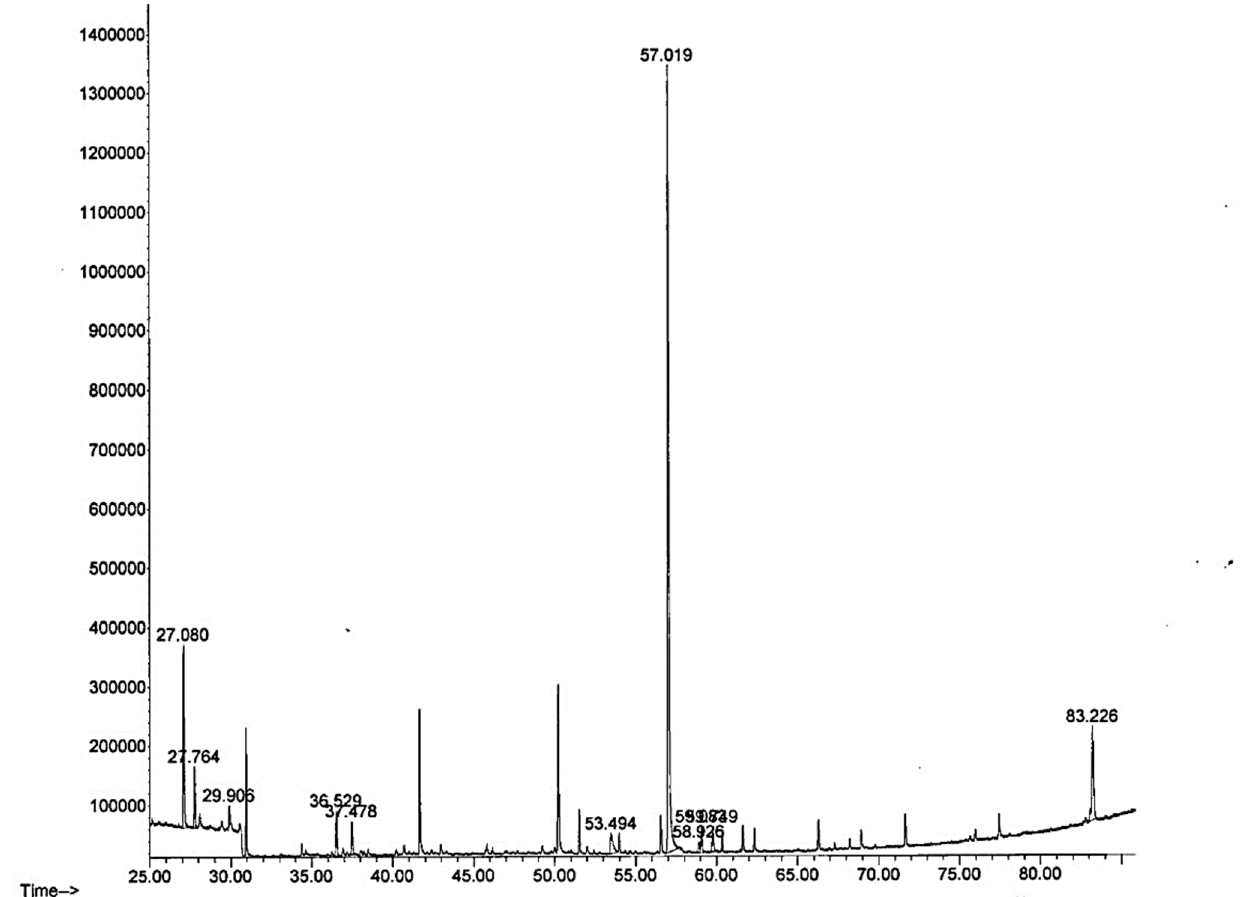
Figure 1. Analysis by gas chromatography and mass spectrometry (GC/MS) of an ethanol extract of E. cava (70%). Chromatograms were obtained by GC/MS analysis of E. cava . Each peak in the chromatogram represents a specific compound obtained with a unique (RT) retention time.